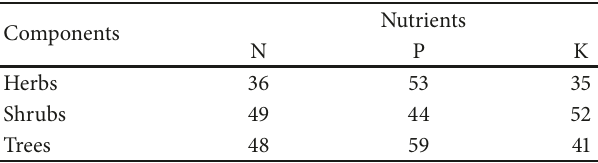
Table 5: Percentage nutrient retranslocation during leaf senescence in moist tropical forest of Sunsari district, eastern